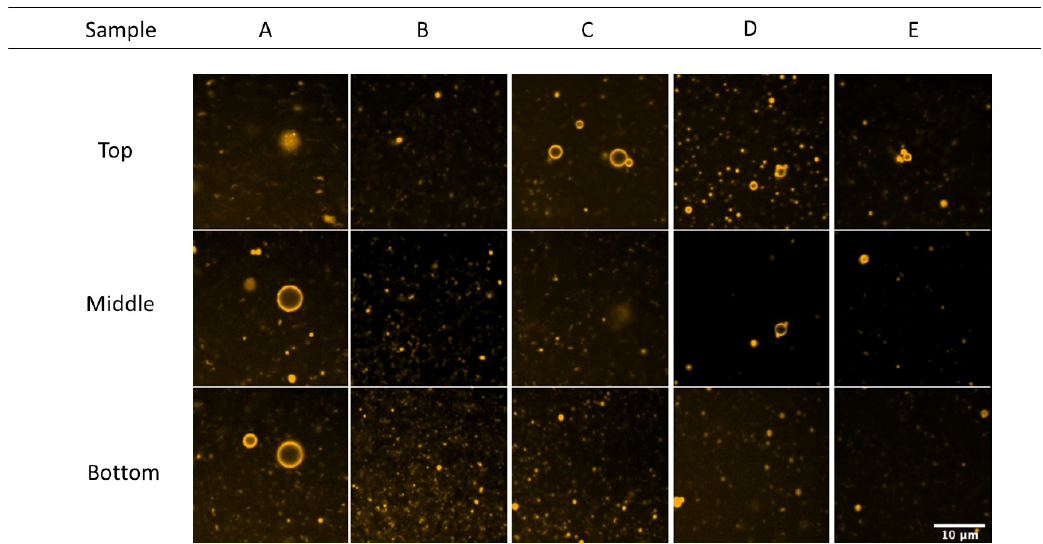
Figure 7. Confocal scanning laser microscopy (CLSM) images at the top, middle, and bottom of the drop emulsions for samples A, B, C, D, and E. This refers to the position in the solution with respect to the two glass surfaces. A and B were obtained from Sigma and Norland, and C, D, and E from different extraction protocols.